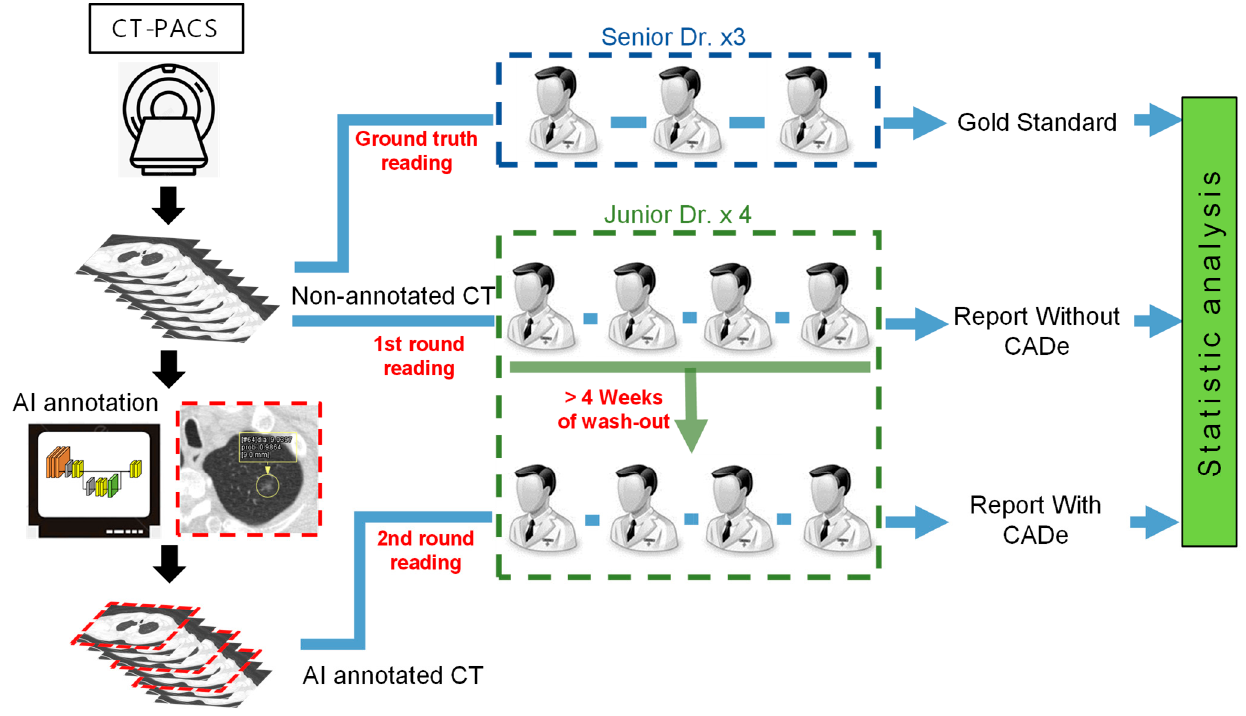
Figure 1. Scheme of the clinical trial of chest CT image examination assisted by AI algorithm in each medical center. The left part demonstrates the simple schema of the image processing flow that produces the non-annotated and annotated CT. Part B demonstrates the multiple-reader multiple-case study, which included four junior doctors in each medical center as clinical readers. In addition, an expert panel of three senior board-certified senior doctors served as the clinical truthers to establish the Ground Truth. The reading process was divided into two reading sessions. During the first reading session, the readers were unaided by AI algorithm detection software. After a wash-out period of at least four weeks, the images were read again with the aid of V5 Pulmonary Image Computer-Aided Detection Software, V5-MED-LU01 (Version:1.0.1, V5 Technologies Co., Ltd., Hsinchu City, Taiwan). After the Ground Truth was established for the CT image of each subject, the samples were randomly sorted and provided to the clinical readers for identification and